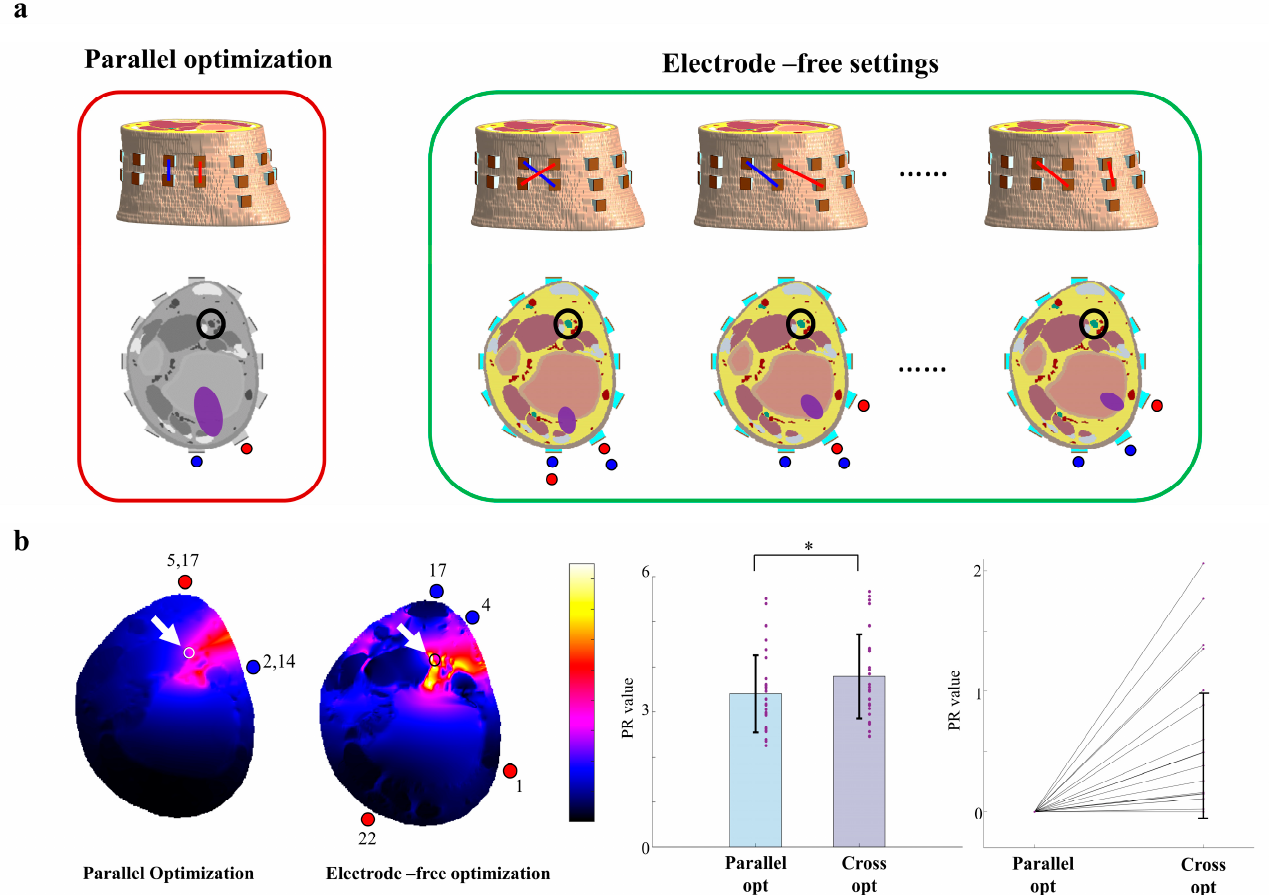
Figure 4. Comparison of TI stimulation results in parallel optimization and electrode-free optimiza- tion ( a ) Concept of electrode arrangement between parallel optimization and electrode-free settings. ( b ) Comparison of parallel opt TI and cross opt TI results, * p < 0.005.